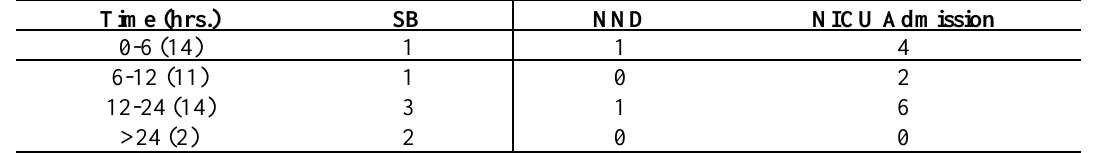
Table VIII : Fetal outcome - fit to delivery time interval (n = 41)* Time (hrs.)